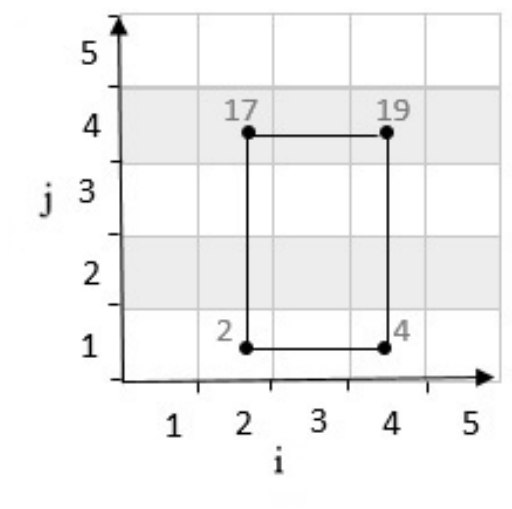
Figure 5. Position of fourth point with positive determinant.